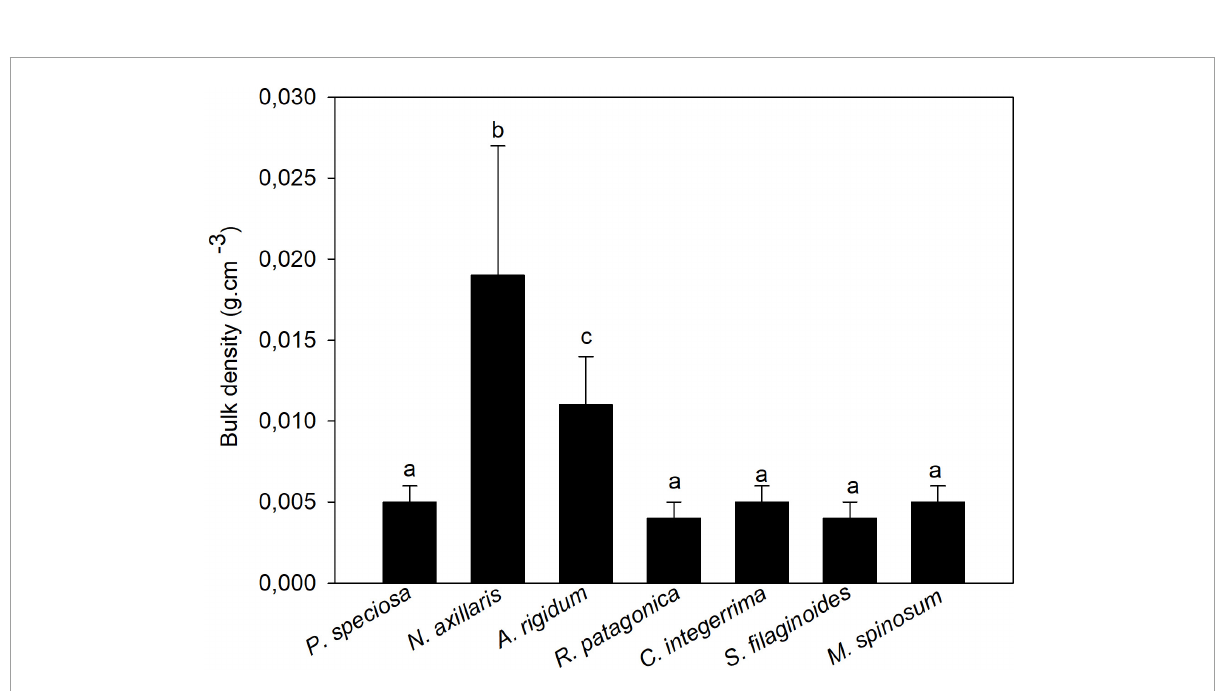
FIGURE6 Mean bulk density ± SD of dominant species. Different letters indicate significant differences among species ( P <